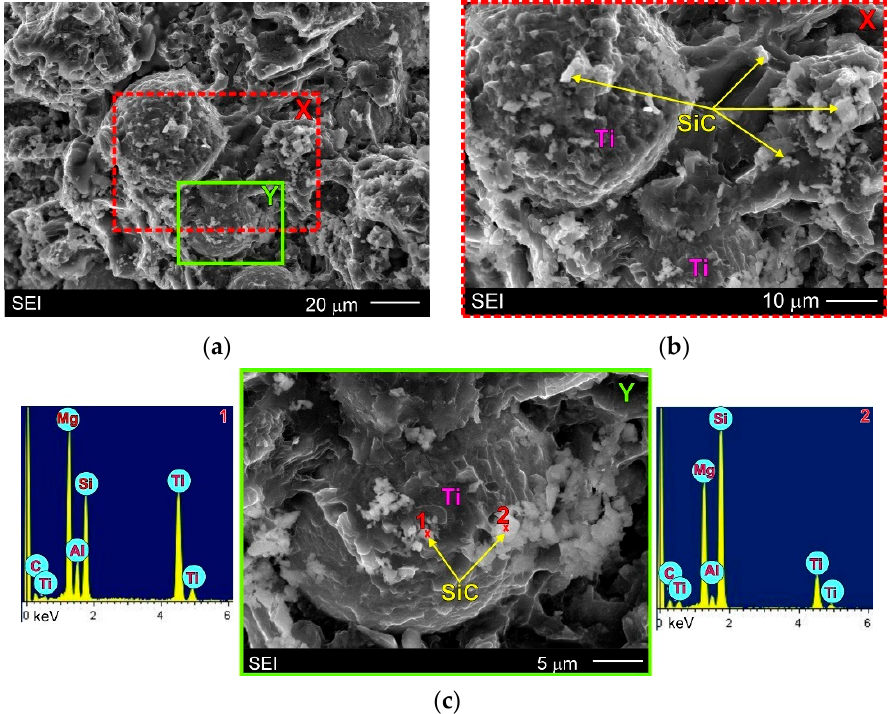
Figure 11. ( a ) SEM micrograph of fracture surface of AZ91/(SiC + Ti) p hybrid composite (after uniaxial tensile test); ( b ) Higher magnification of area marked as X on ( a ) micrograph; ( c ) Higher magnification of area marked as Y on ( a ) micrograph with EDX results in form of X-ray spectrums from designated points.